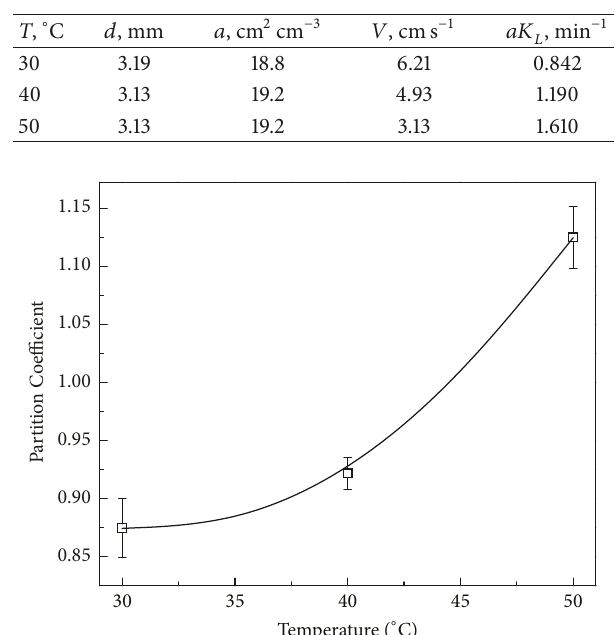
Table 3: Experimental values of drop size ( 𝑑 ), terminal velocity ( 𝑉 ) and masstransfercoefficients (continuous phaseside)( 𝑎𝐾 𝐿 ) at three different temperatures. Single drop tests, 𝜙 = 0.15 .